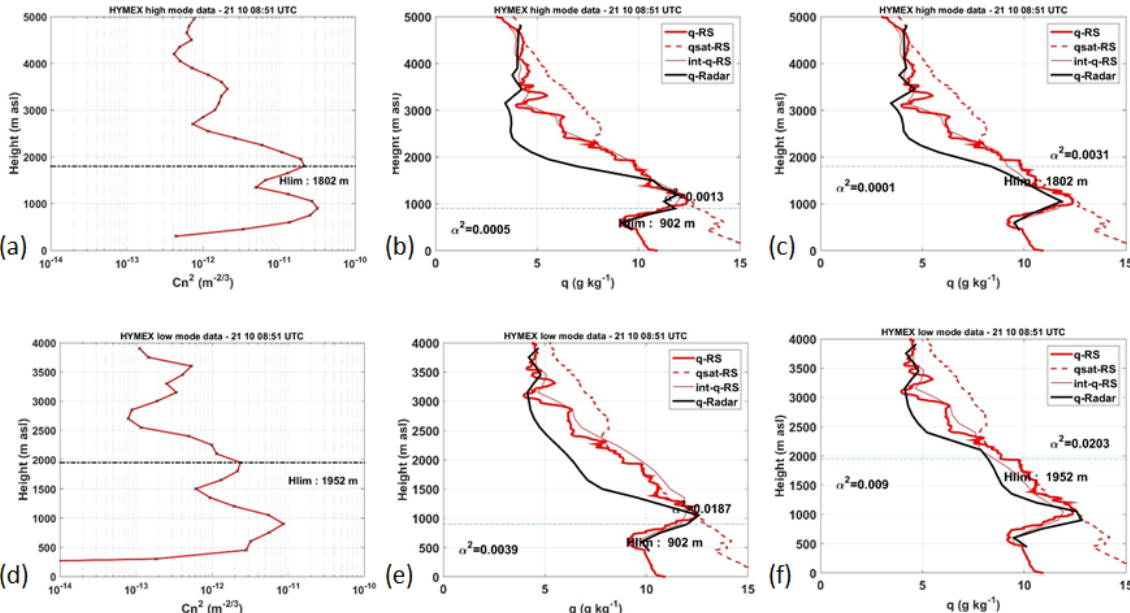
Figure 2. Radar turbulence structure parameter C 2 n (a, d) and humidity profiles (same details as in Fig. 1c) for different Hlim levels. Panels (b) and (e) illustrate the WPR specific humidity profile (q-Radar) obtained considering the value of Hlim corresponding to the dominant C 2 n peak observed in panels (a) and (d) , respectively. Panels (c) and (f) illustrate the WPR specific humidity profile obtained considering the value of Hlim corresponding to a different relative maximum of the C 2 n profile. In panels (b) , (c) , (e) and (f) , the RS specific humidity profile (q-RS), the saturation specific humidity profile (qsat-RS) obtained from RS pressure and temperature profiles, and the saturation specific humidity profile (int-q-RS) obtained by integrating RS vertical gradient of refractivity ( M RS ) are shown. Panels (a) , (b) and (c) are for the high mode (vertical resolution 375m, interpolated every 150m), while panels (d) , (e) and (f) are for the low mode (vertical resolution